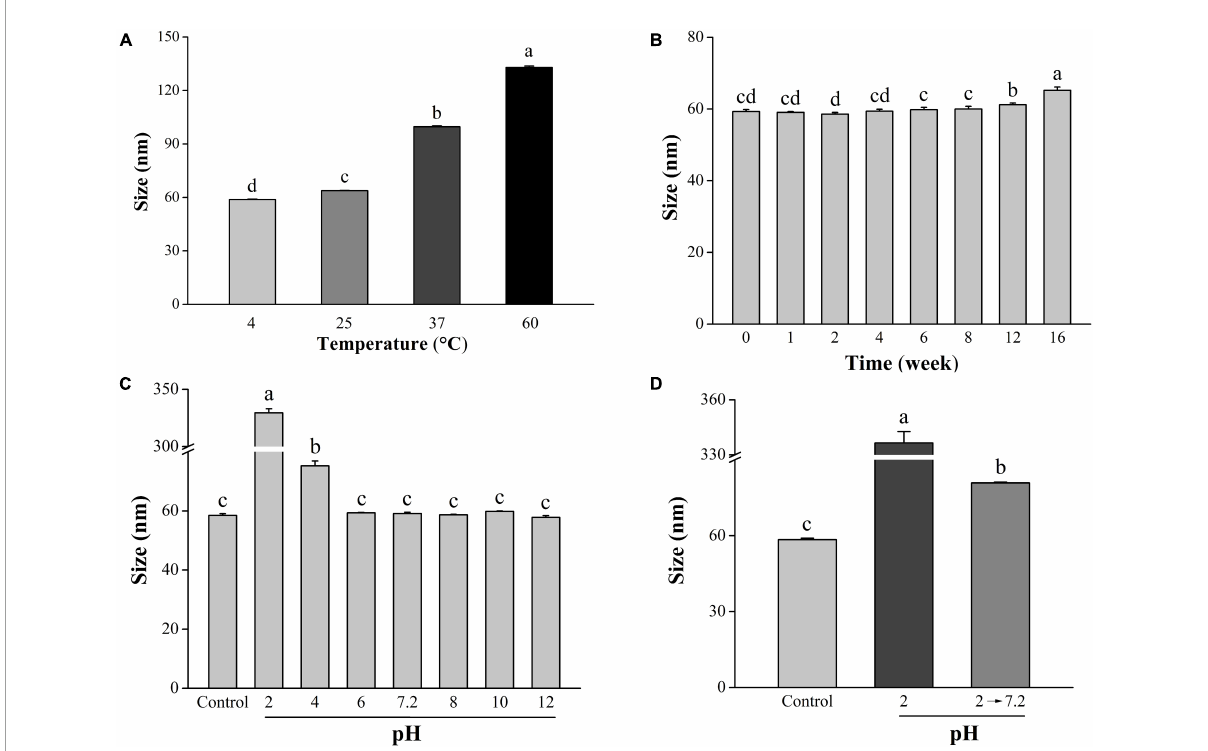
FIGURE3 Effects of temperature, storage time, and pH on the stability of LNT-SeNPs. Changes in the average particle diameter of LNT-SeNPs placed in 4, 25, 37, and 60 ◦ C for 3 days (A) . Changes in the average particle diameter of LNT-SeNPs stored at 4 ◦ C for 0–16 weeks (B) ; effect of pH on the average particle diameter of LNT-SeNPs (C) . Effect of pH at simulative gastrointestinal environments on the average particle diameter of LNT-SeNPs (D) . Data were shown as mean values ± SD ( n = 3). Different letters represented significant differences ( p < 0.05).